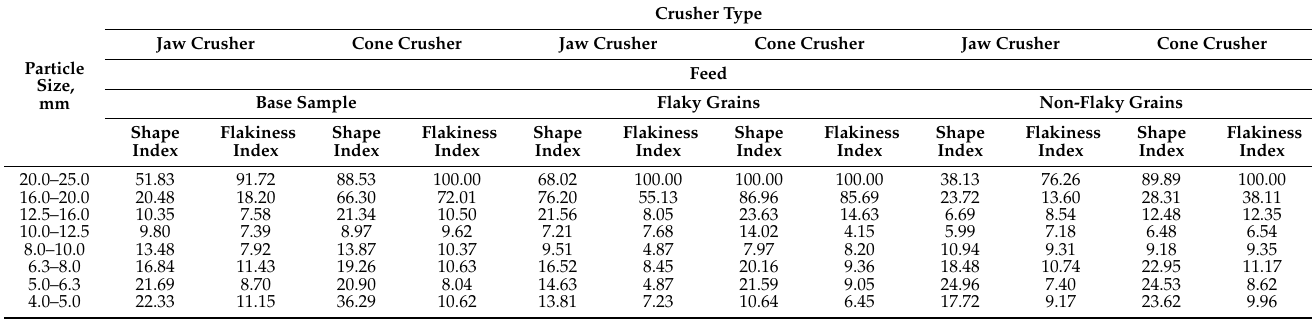
Table 3. Average shape and flakiness indexes for the analyzed basalt aggregate 1 after